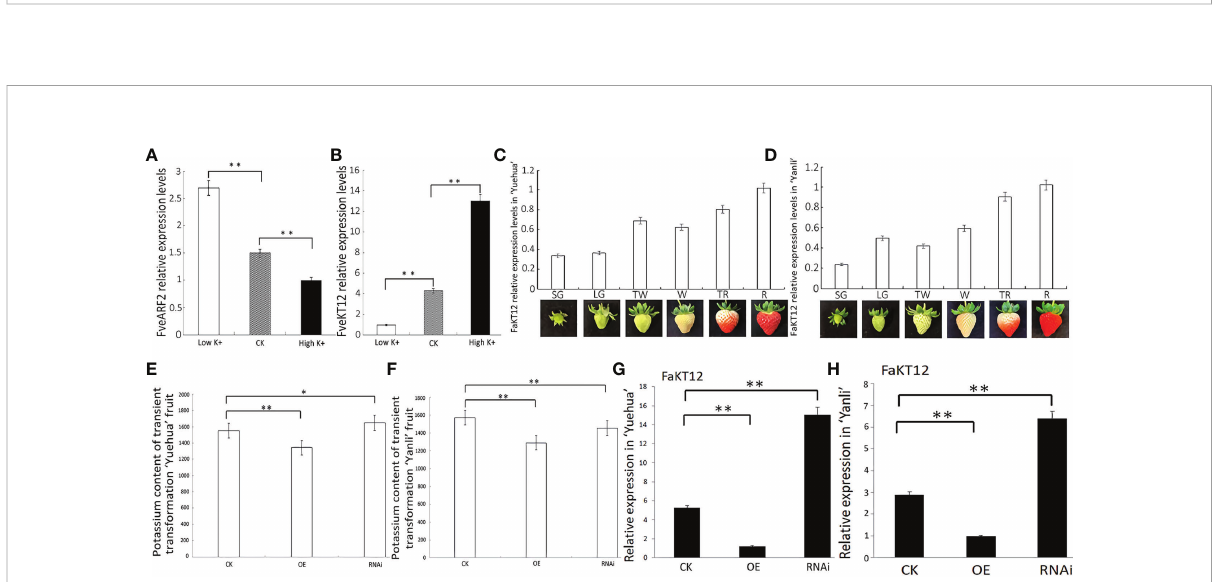
FIGURE 9 FveARF2 is involved in potassium transport in ‘ Yuehua ’ and ‘ Yanli ’ transgenic fruit. (A) FveARF2 relative expression levels after 12 h of treatment with high K + and low K + conditions. (B) FveKT12 relative expression levels after 12 h of high K + and low K + treatment. (C, D) FaKT12 relative expression levels in different fruit development stages in ‘ Yuehua ’ and ‘ Yanli ’ strawberry cultivars. (E, F) Potassium content in transgenic ‘ Yuehua ’ and ‘ Yanli ’ fruit. (G, H) FaKT12 relative expression levels in transgenic ‘ Yuehua ’ and ‘ Yanli ’ fruits. Values are the mean ± SD from three independent experiments with three biological replicates. ‘ * ’ Indicates signi fi cant differences (P < 0.05, Duncan ’ s multiple range test); ‘ ** ’ indicates very signi fi cant differences (P < 0.01, Duncan ’ s multiple range